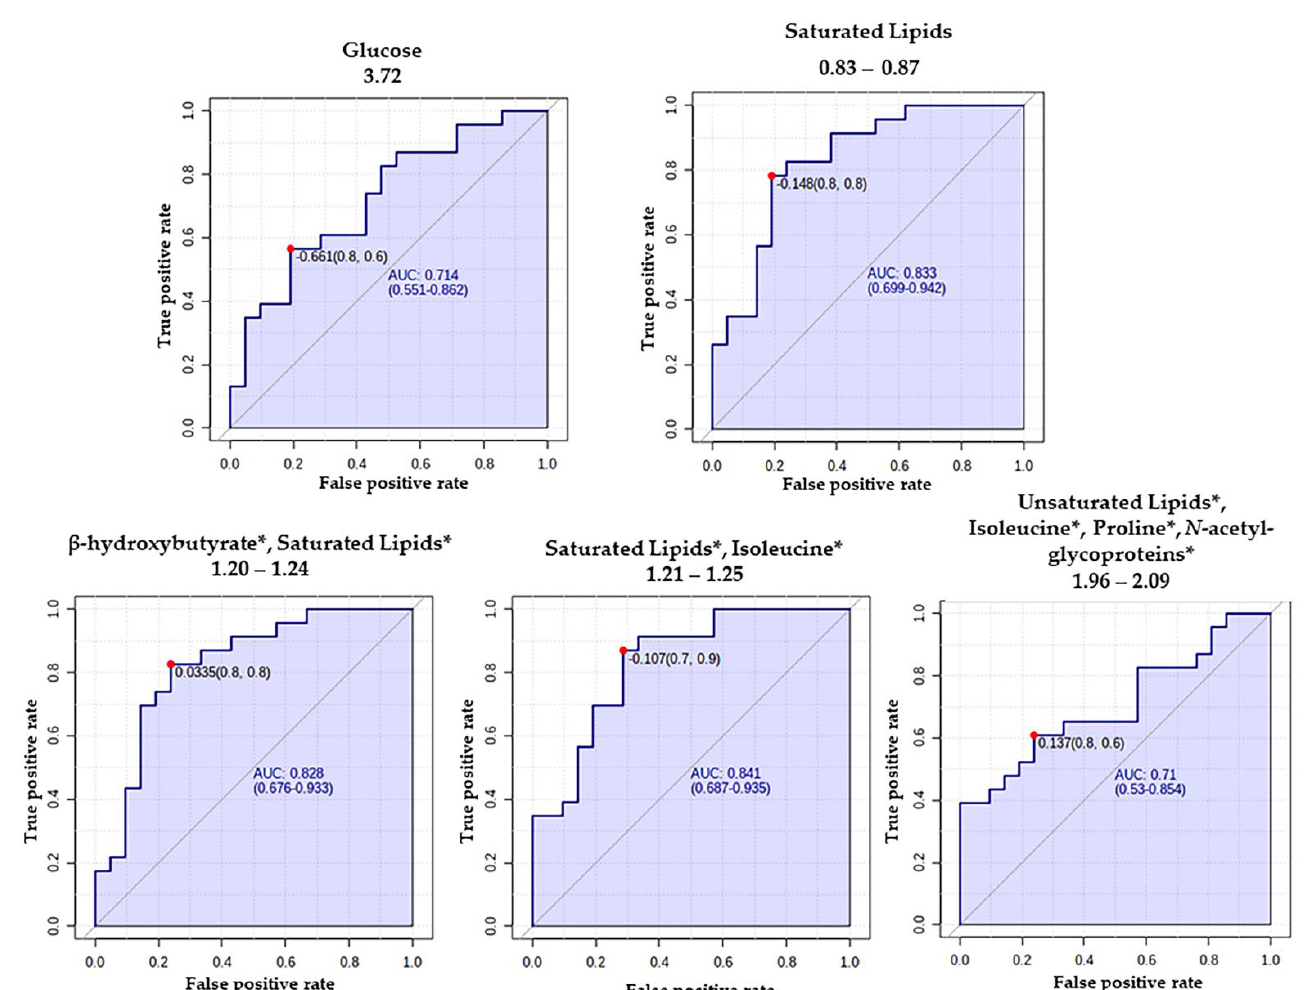
Figure 3. Receiver operator characteristics (ROC) curves and their respective areas under the curve (AUC) were calculated for the most important features determined by VIP values to compare MTLE patients and controls. * = overlaid signals.